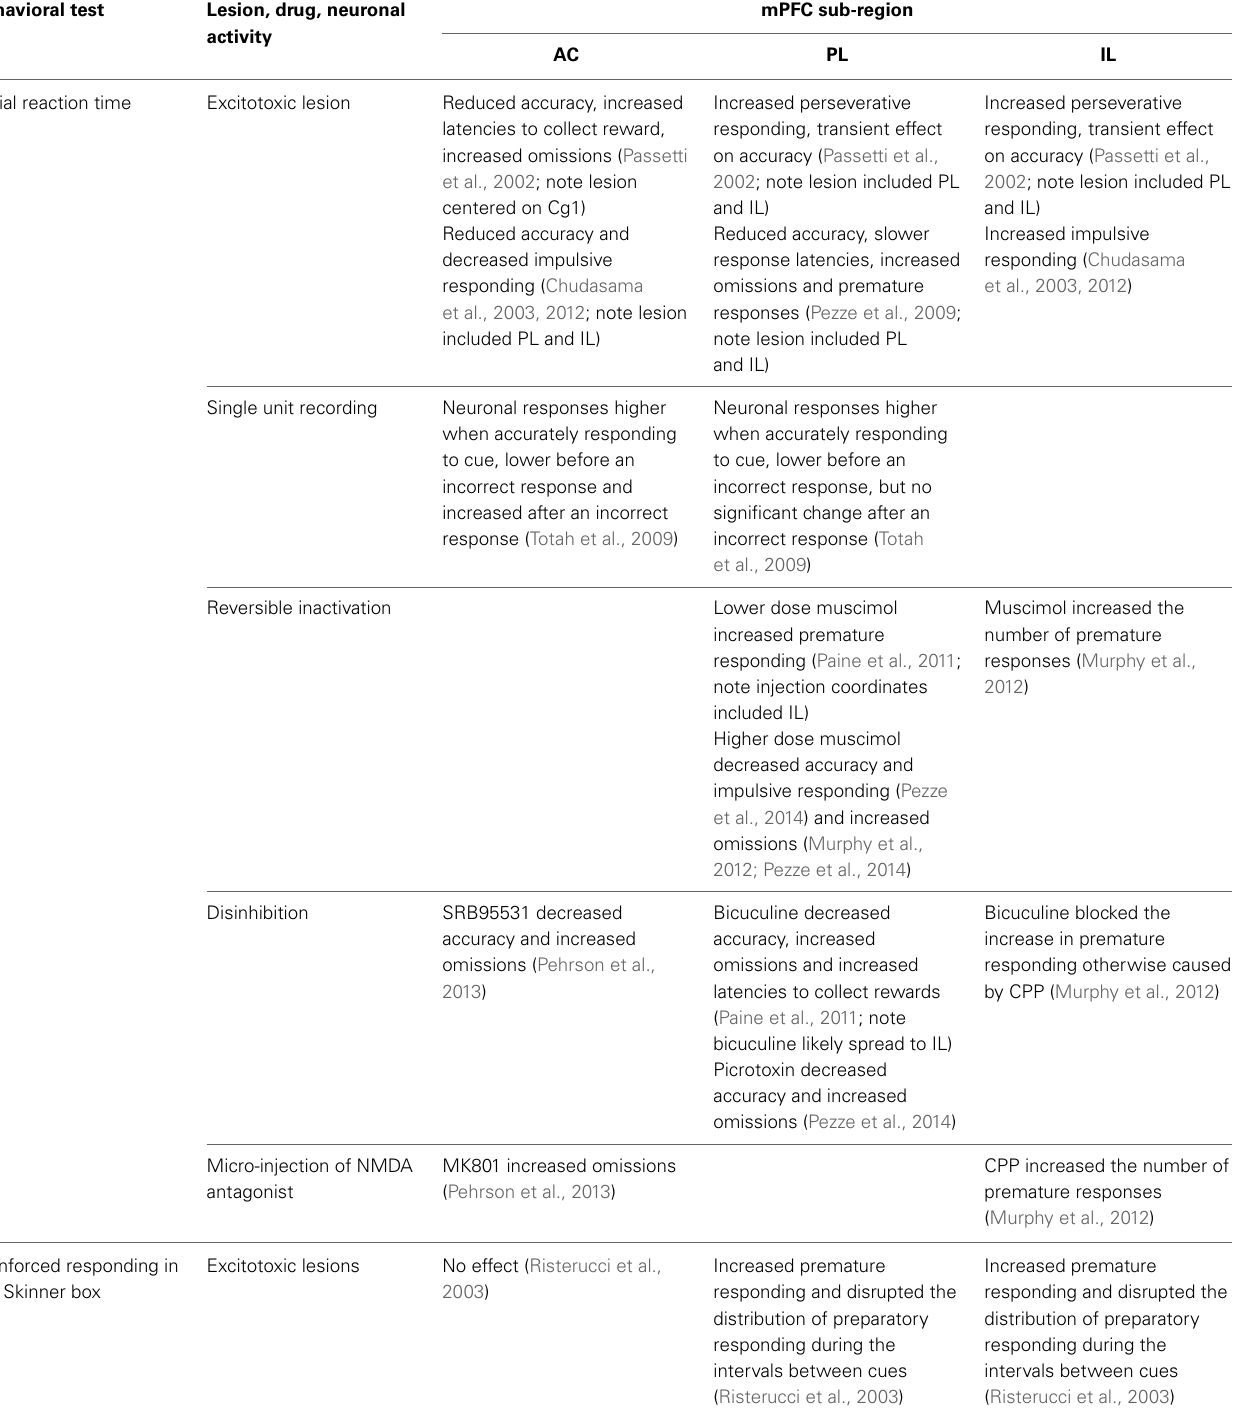
Table 1 | The behavioral effects associated with changes in neuronal activity in anterior cingulate (AC), prelimbic (PL), and infralimbic (IL) sub-regions of medial prefrontal cortex (mPFC) in tasks measuring serial reaction time, latent inhibition, trace conditioning and object recognition, as well as related benchmark tests of learning and memory (for which the effects of similar interventions in different mPFC sub-regions have been